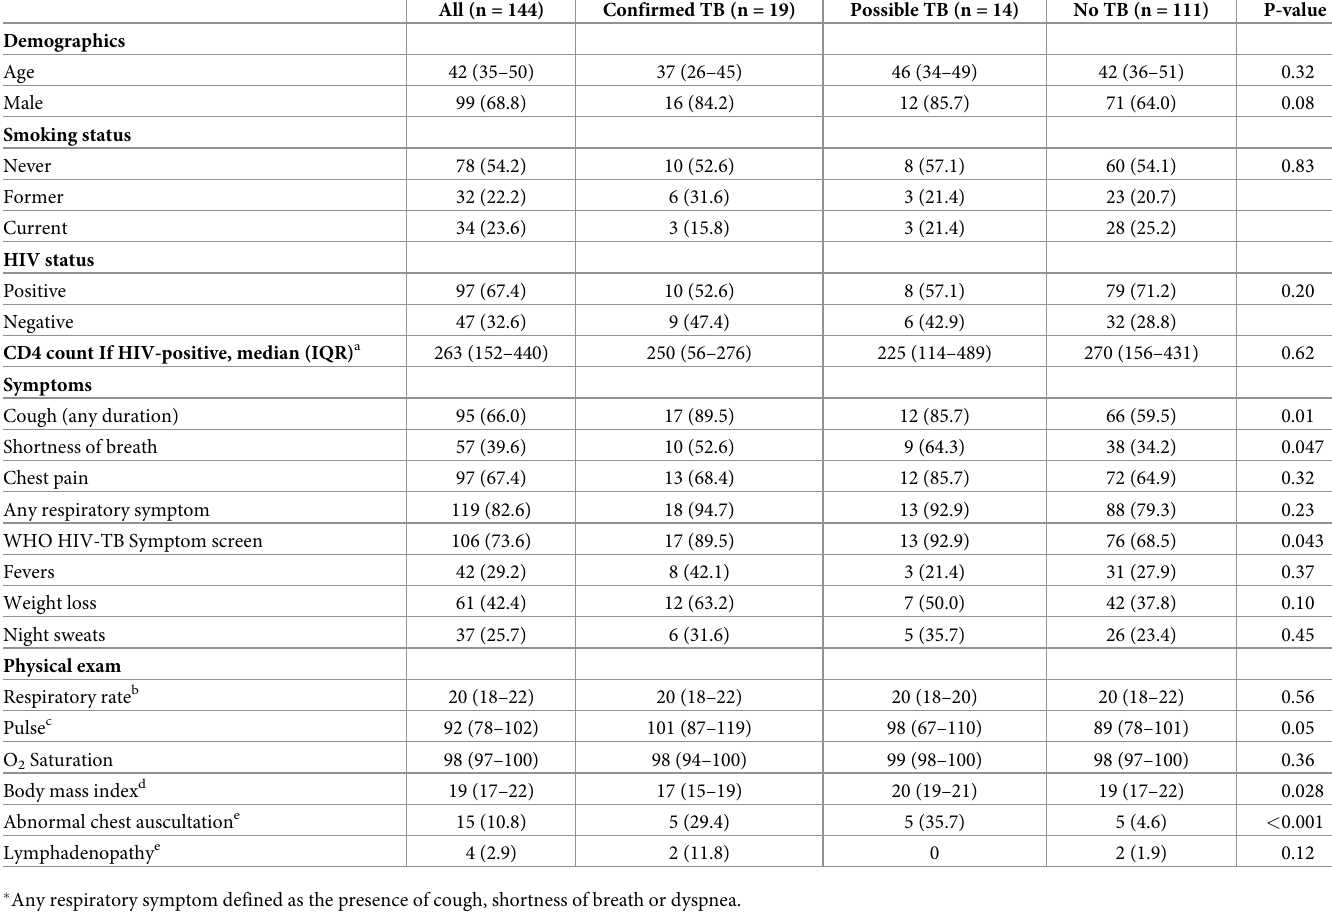
Table 1. Overview of baseline characteristics among presumptive TB patients with a prior history of TB, according to their current TB disease classification (n =